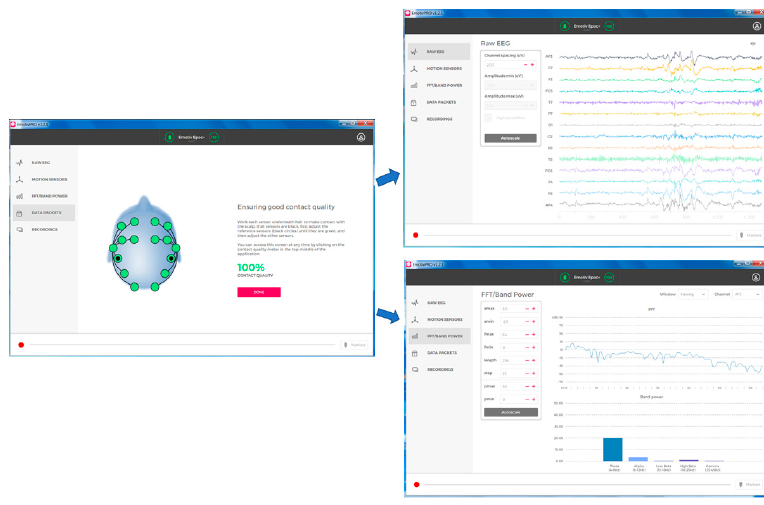
Figure 3. The EmotivPRO software for device set up and EEG monitoring.